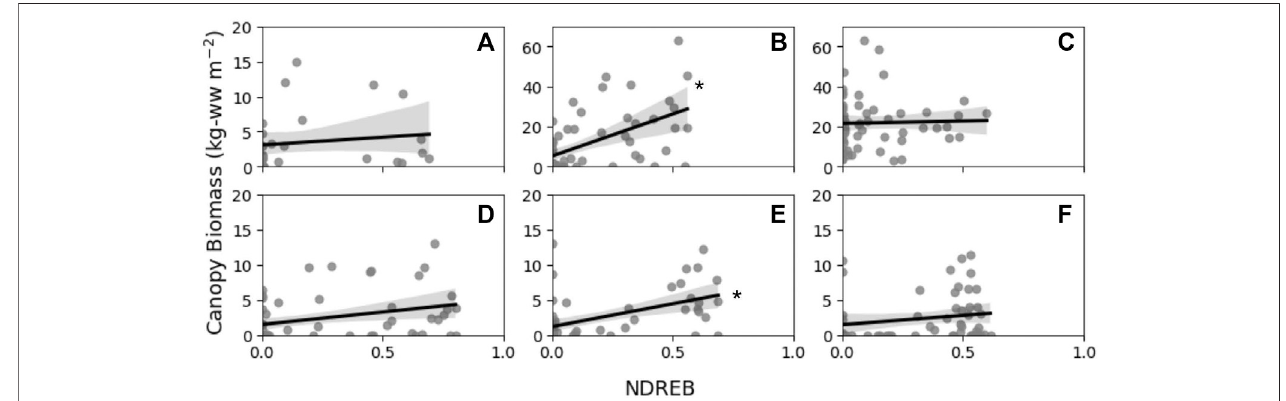
FIGURE7| Transectintervalcanopybiomassinkgwetweight(kg-ww)against averageNDREBvaluesfroma1.5 mradius aroundeachtransectinterval (A) Noyo Harbor; (B) PortugueseBeach; (C) PointPiños; (D) OtterCove; (E) SanCarlosBeach; (F) HopkinsMarineStationwithOLSregression(black lines)and95%con fi dence intervals (grey shading). Signi fi cance of the OLS regression is indicated with an asterisk. See Table 6 for each sampling radii and site ’ s regression statistics.